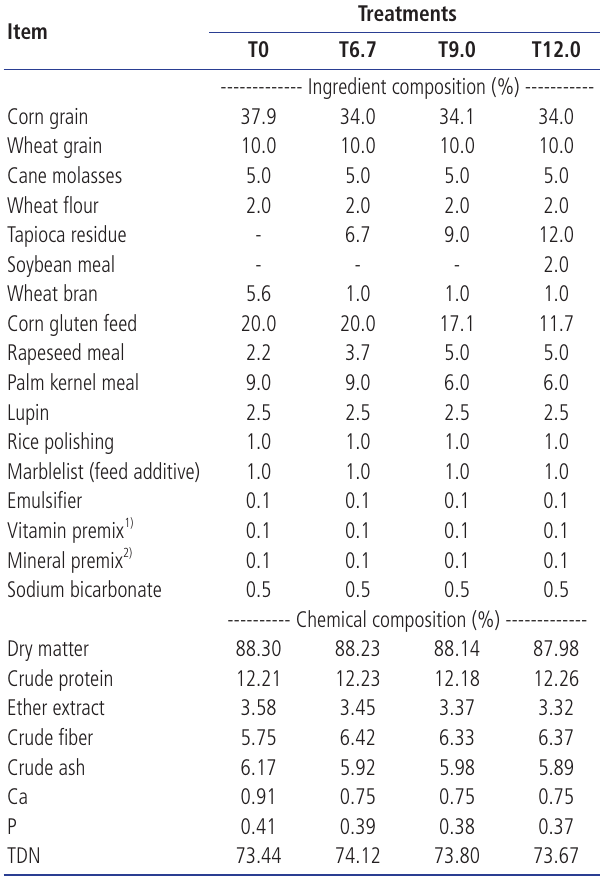
Table 1. Ingredient and chemical compositions of the experimental diets of Hanwoo steers Item